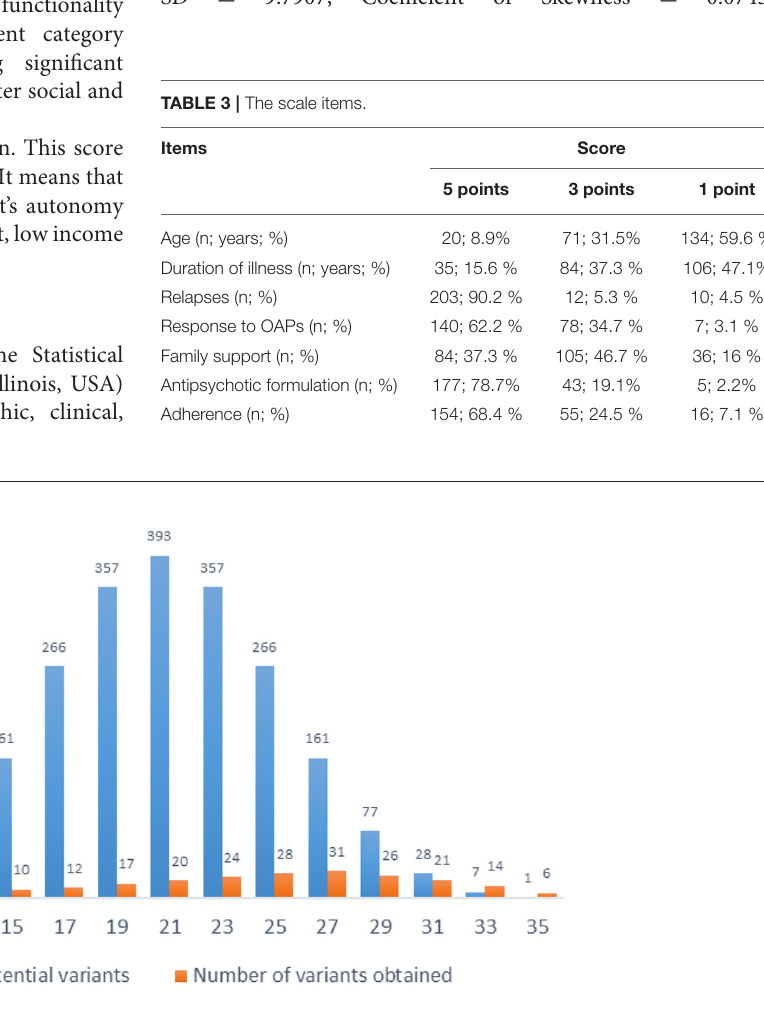
FIGURE 1 | The distribution of ROLIN